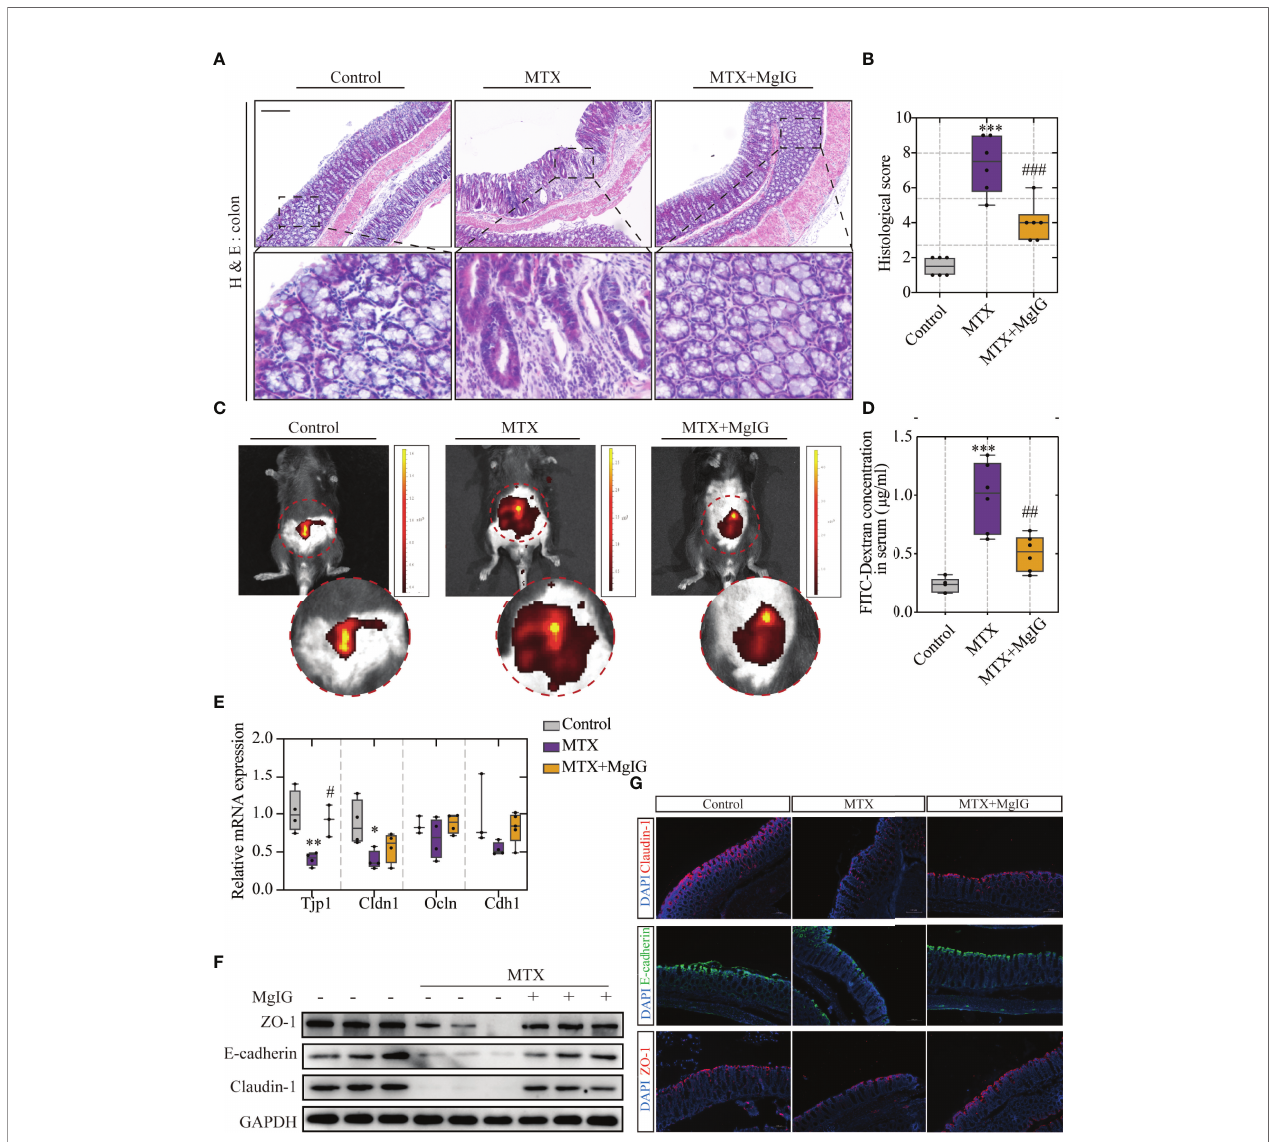
FIGURE 3 | MgIG alleviated MTX-induced intestinal injury. (A) Representative H&E staining of colon tissue sections from each group, Scale bar, 200 m m. (B) Histological score in each group (n = 6, Kruskal-Wallis test). (C) Representative In vivo imaging of FITC-Dextran. (D) Intestinal leakage measured by FITC-Dextran concentration in serum (n = 6, One-way ANOVA). (E) Relative mRNA expression of tight junctions in liver tissue from each group (n = 3-5). (F) Immunoblot analysis of ZO-1, E-cadherin and Claudin-1 in colon tissues (n = 3). (G) Immuno fl uorescence analysis on ZO-1, E-cadherin and Claudin-1 in colon sections from different groups. Representative images are shown. Scale bar, 100 m m. *p < 0.05, **p < 0.01, ***p < 0.001, compared with Control group. # p < 0.05, ## p < 0.01, ### p < 0.001, compared with MTX